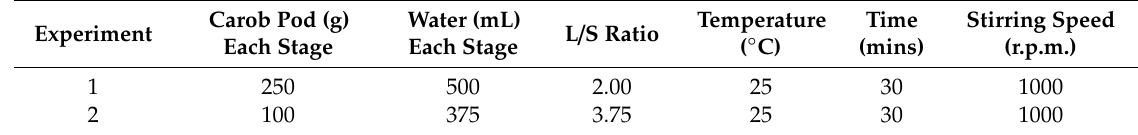
Table 1. Operation conditions for the four-stage counter-current system. L / S: liquid / solid ratios. Temperature Time Stirring Speed Carob Pod (g) Water (mL) L / S Ratio Experiment ( ◦ C) (mins) (r.p.m.) Each Stage Each Stage 250